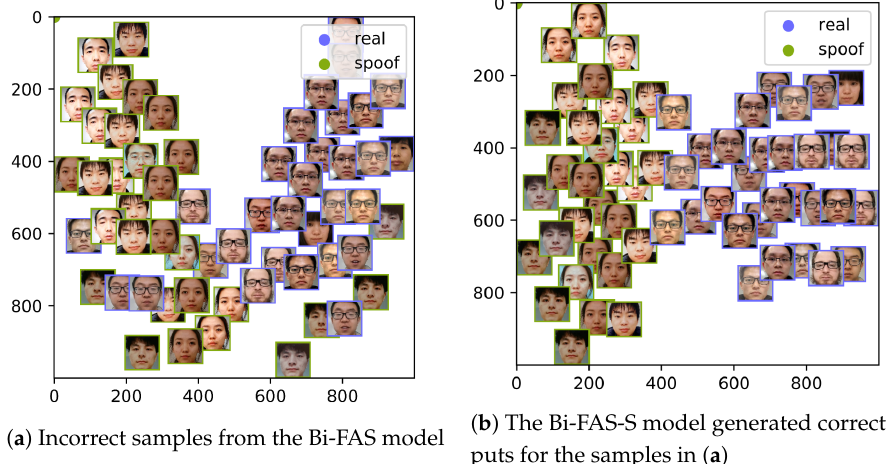
Figure 7. Visualizations of the P 3 outputs of the incorrect samples from the Bi-FAS model and indications that they were corrected by the Bi-FAS-S model on Protocol I of OULU-NPU